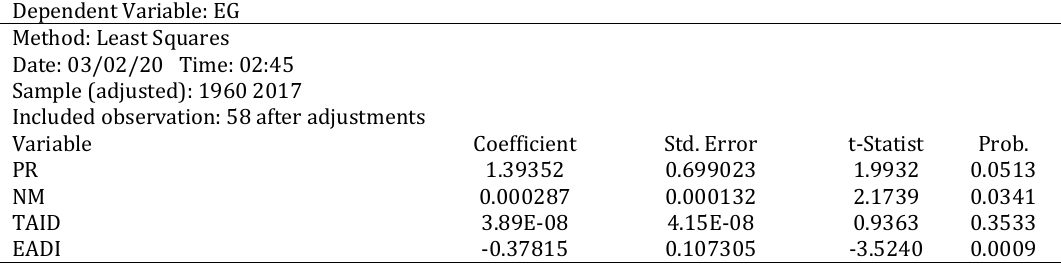
Table 17: Estimation of economic growth model Dependent Variable: